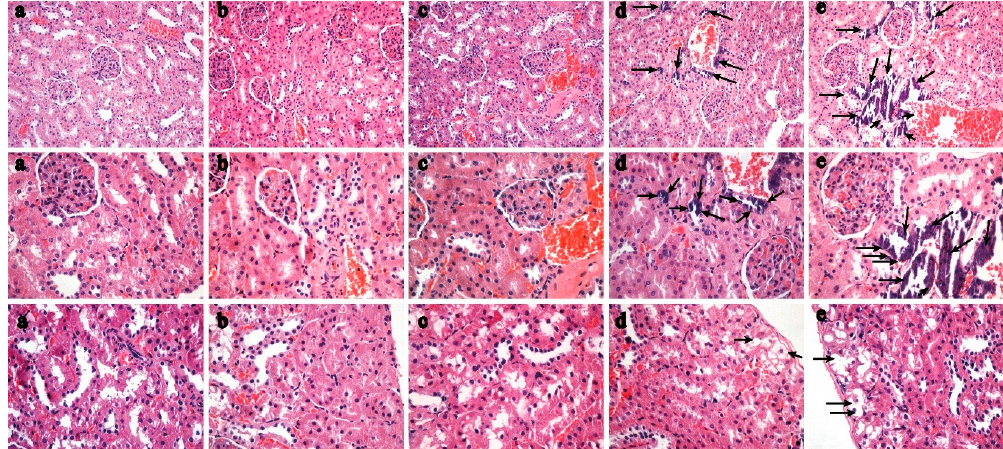
Figure 1. Representative HE images of kidney in female rats fed the AIN93G diet without Cd (control) ( a ), with 1 mg Cd/kg diet ( b ), and with 1 mg Cd/kg diet plus 0.15% Ca supplementation ( c ), with 1 mg Cd/kg diet plus 0.4% Ca supplementation ( d ), with 1 mg Cd/kg diet plus 0.6% Ca supplementation Ca ( e ). Tubular epithelial cell calcification and tubular vacuolation are shown in Figure 1( d,e ).